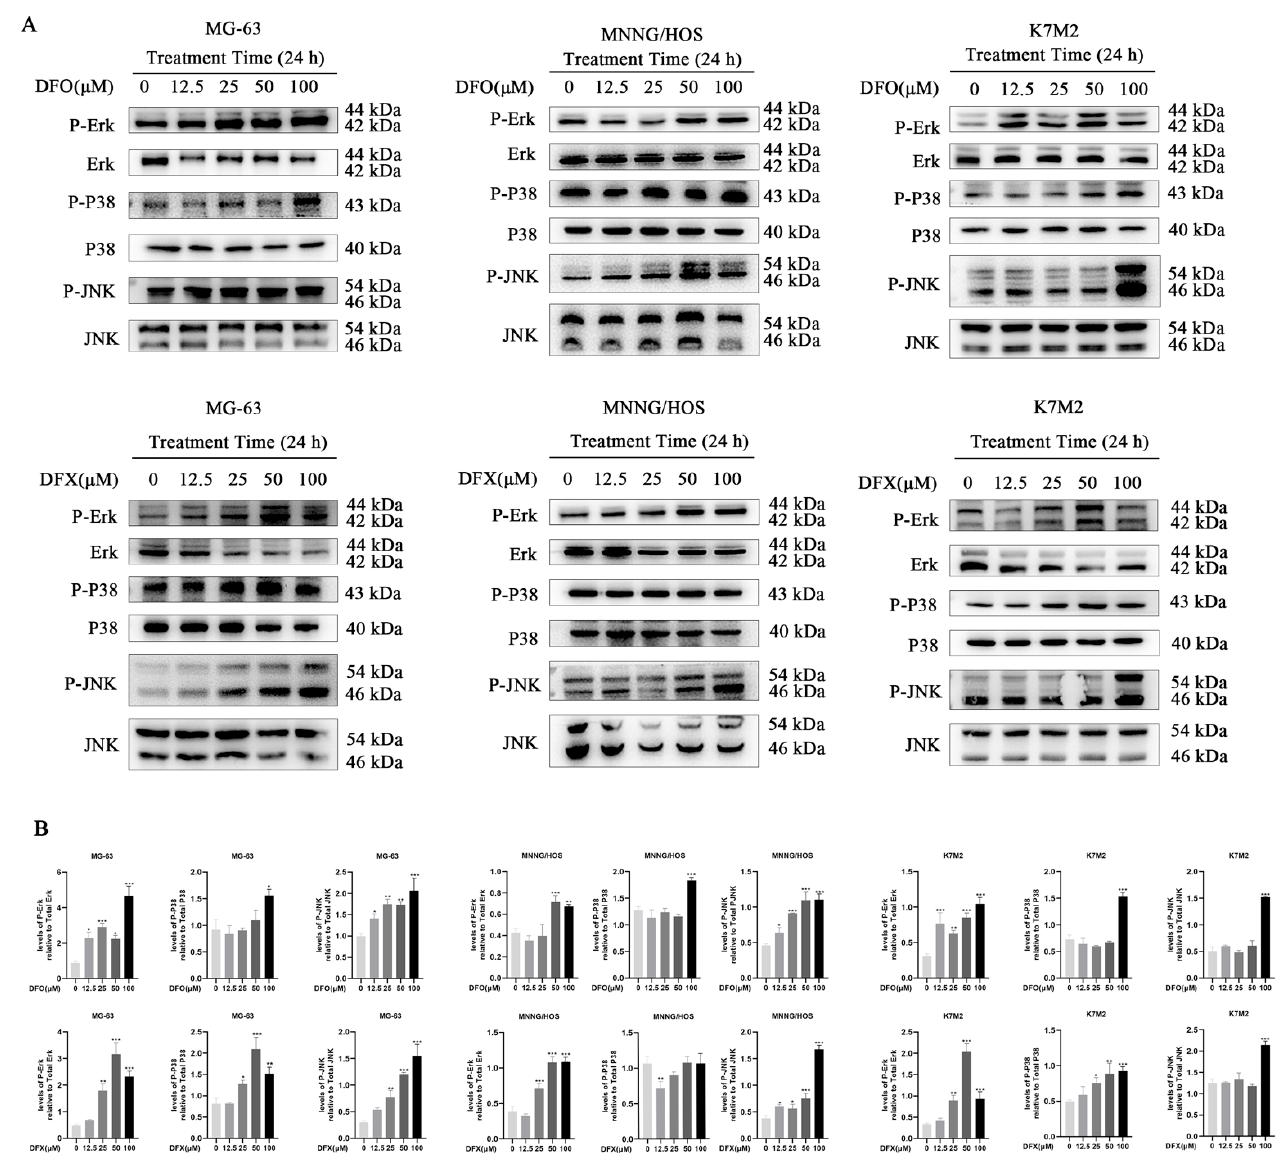
Figure 6. Iron chelators activated the MAPK signaling pathway in osteosarcoma cells. ( A ) Phosphorylation levels of p-Erk, p38 and JNK in MG-63, MNNG/HOS and K7M2 cells treated with the indicated concentrations of DFO and DFX for 24 h. ( B ) Quantitative analysis of P-Erk, Erk, P-P38, P38, P-JNK and JNK in MG-63, MNNG/HOS and K7M2 cells treated with the indicated concentrations of DFO and DFX for 24 h (n = 3). * p < 0.05, ** p < 0.01 and *** p < 0.001 versus control group.